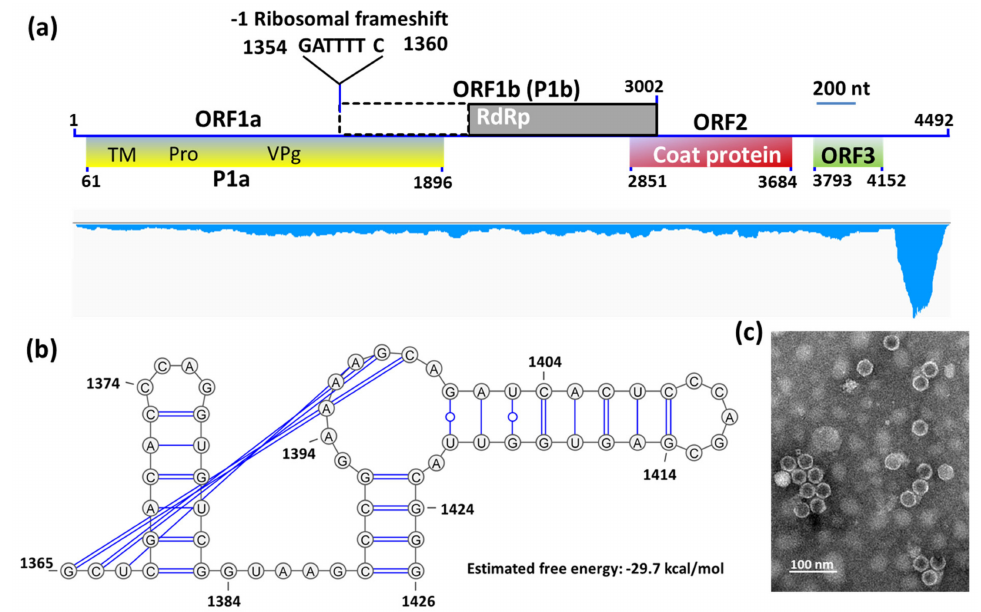
Figure 3. ( a ) Schematic organization and annotations of the Hubei sclerotinia RNA virus 1 (HuSRV1) genome (upper panel) and its distribution profile of transcriptomic reads (lower panel). Four putative ORFs (ORF1a, ORF1b, ORF2, and ORF3) are shown as rectangular boxes in di ff erent colors. TM, transmembrane domain; Pro, serine protease; VPg, Viral protein linked to the genome; and RdRp, RNA-dependent RNA polymerase. The dotted area in ORF1b indicates the predicted -1 ribosomal frameshifting for RdRp. The bar at the upper right of the genome structure of HuSRV1 represents the length of 200 nucleotides (200 nt). The mapped reads were more numerous in 3’-UTR than the coding regions, intergenic regions, and 5’-UTR of the genomes. ( b ) Schematic representation of -1 ribosomal frameshifting in ORF1b. The secondary structure of RNA was predicted with the KnotSeeker program. ( c ) Transmission electron microscopy examination of negatively stained purified virions of